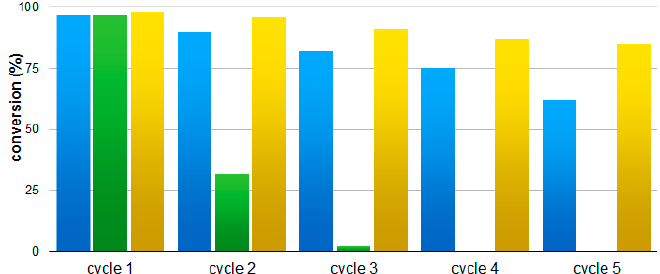
Figure 4. Recyclability as a function of the catalyst. Blue: Au–SILP; green: Au–SiO 2 @IL(Cl); yellow: Au–SiO 2 @IL(PF 6 ).